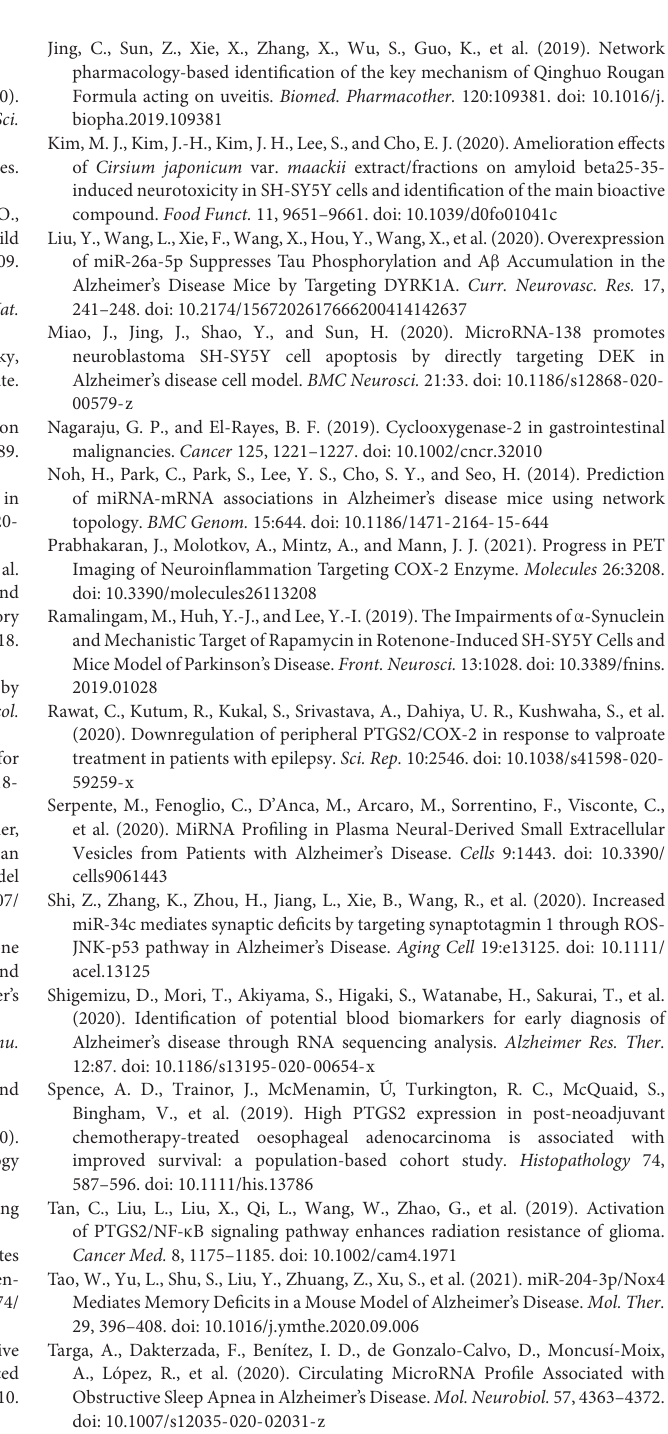
Alzheimer’s disease.